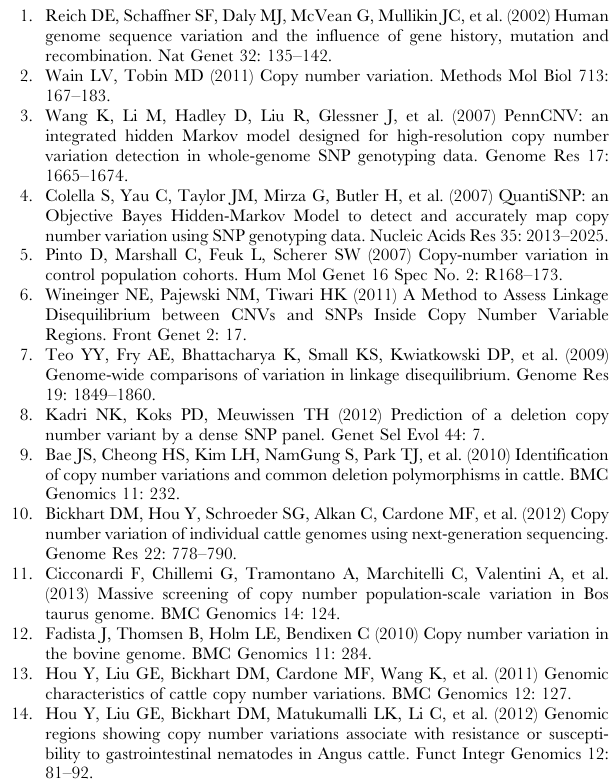
Figure S1 Figures S1–S7: MAF Distribution. Average proportions of SNPs of various frequencies per breed and per groups. File S1 Table S1. Breeds and number of animals in the sample. File S2 Table S2. Final summary of markers for our study. (XLSX)